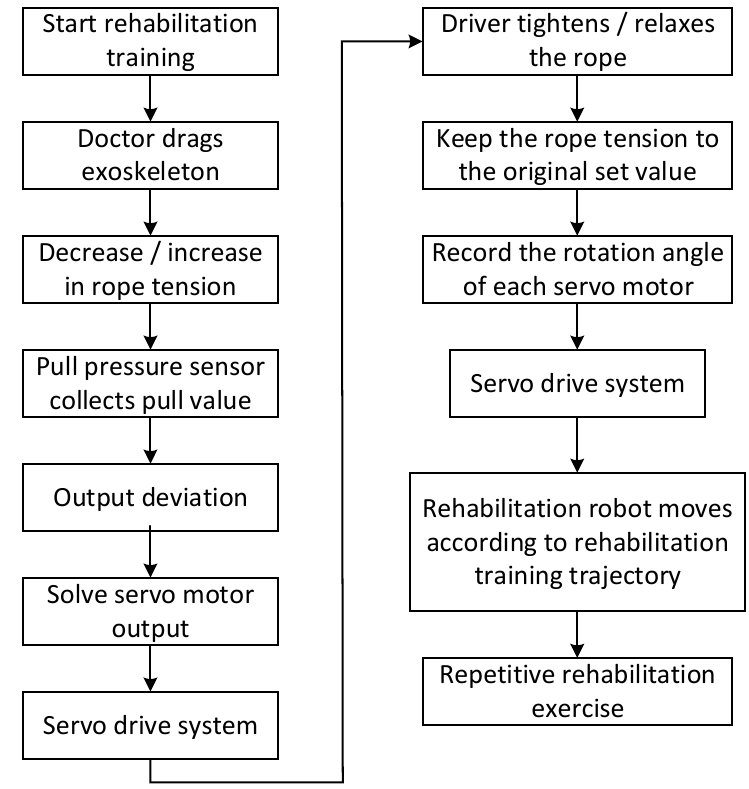
Figure 5. The dragging teaching system.